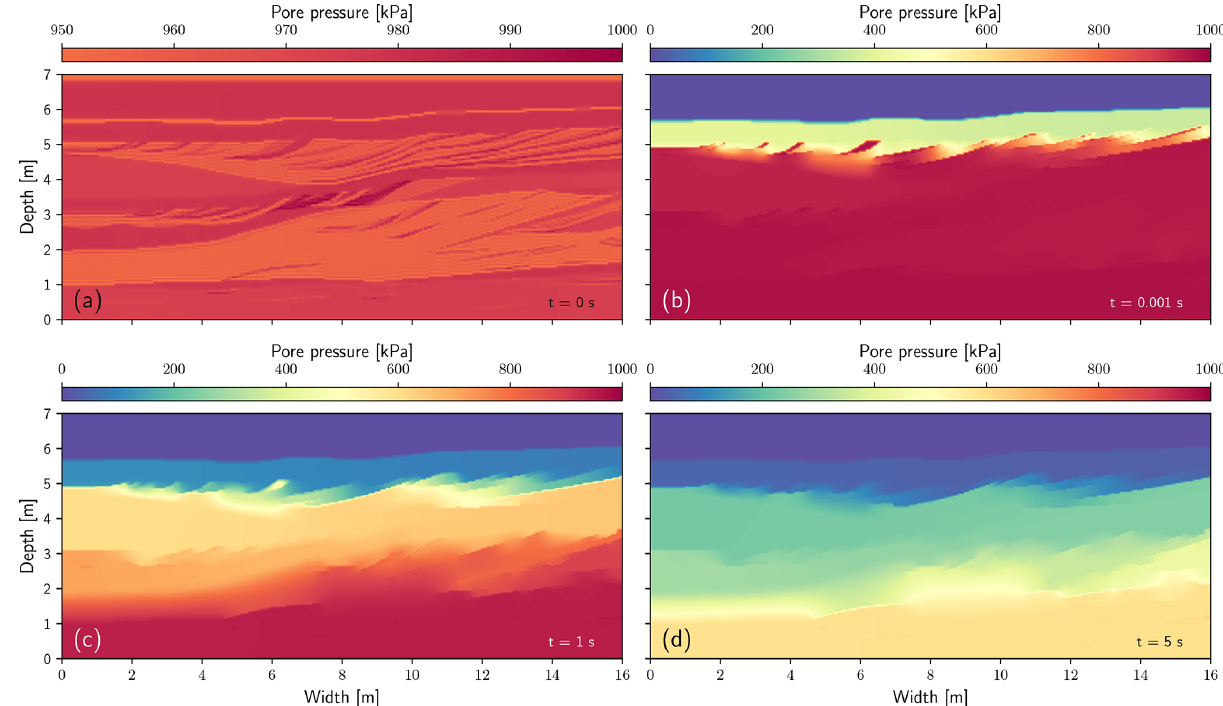
Figure 5. Sequence of snapshots of the consolidation process and pore pressure variation in the aquifer with time. (a) Initial condition of the simulation. (b) Snapshot at time 1 × 10 − 3 s. (c) Snapshot at time 1s. (d) Snapshot at time 5s. Note that (a) uses a different colour range to highlight the small variations in pore